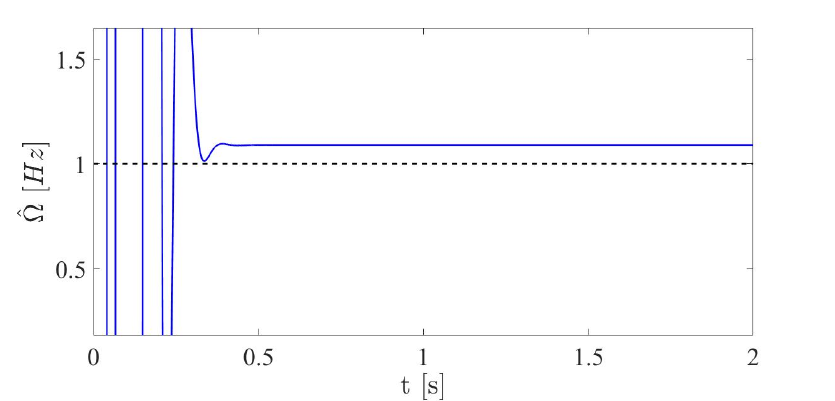
Figure 8. Dynamic performance of the linear pendulum absorber.